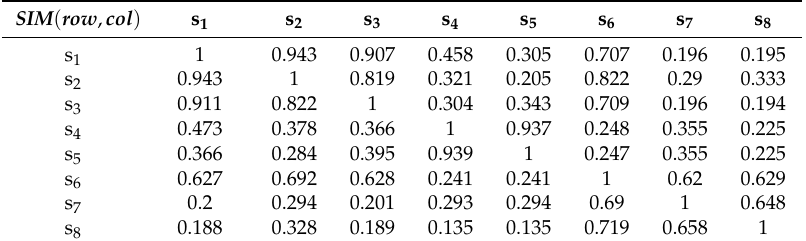
Table 7. Semantic similarity table.